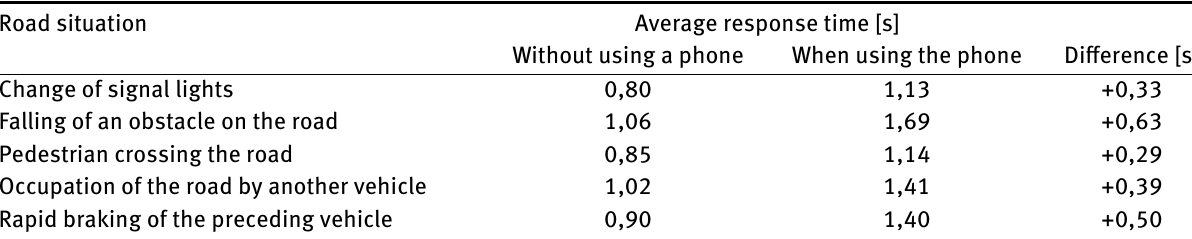
Table 5: Comparison of reaction times in different traflc situations [12]. Road